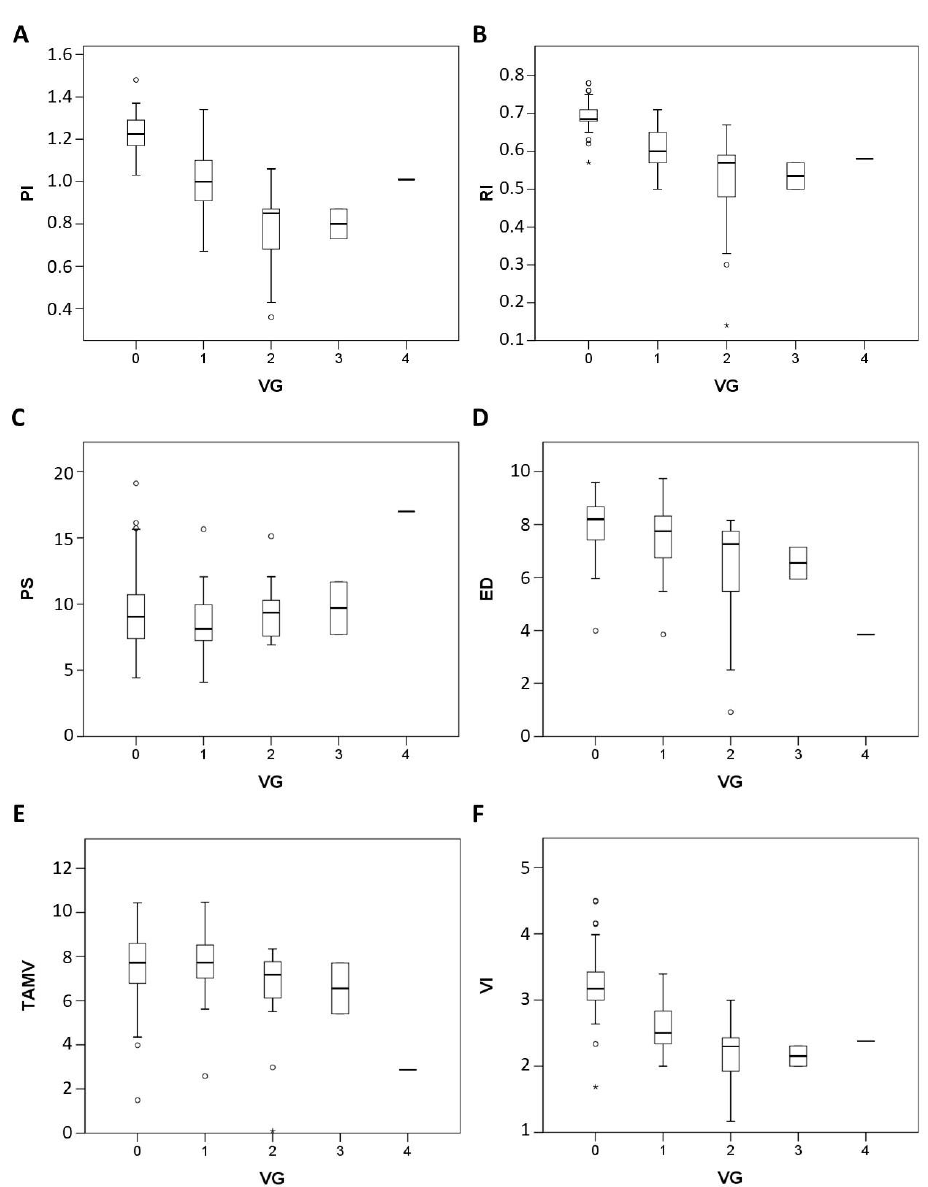
Figure 5. Box plot showing the correlation between the vascular grading (VG) and 6 sonographic parameters of cervix (PI, RI, PS, ED, TAMV, VI) in study group (N = 38) and control group (N = 41). ( A , B , D , F ): A negative correlation can be seen in PI, RI, ED and VI. ( C , E ): No specific trend in PS and TAMV. * Extreme outlier, o Outlier.